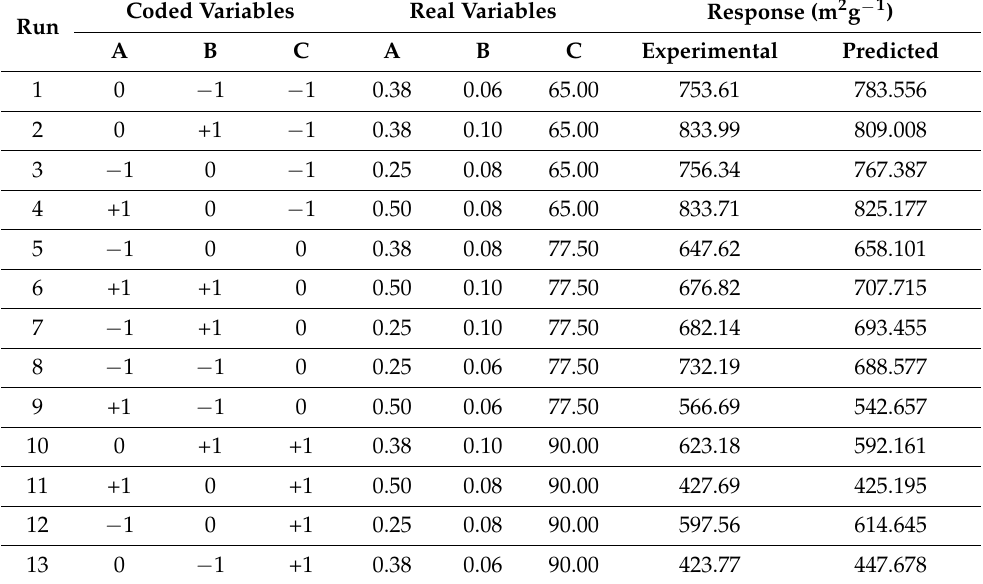
Table 3. Experimental and predicted surface area under different conditions. A: mass of template, B: amount of triethanolamine (TEA) & C: reaction temperature